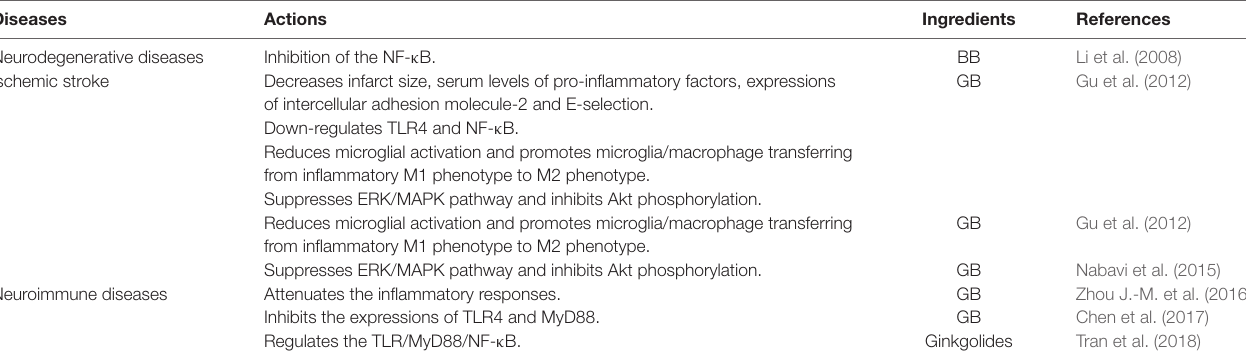
TABLE 2 | Roles of ginkgolides in IIR in neurological